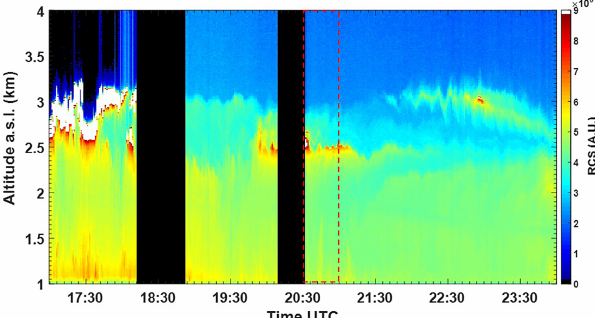
Figure 4. EARLINET IISTA-CEAMA lidar RCS time series at 532nm, 16 June 2016 (17:00 to 00:00UTC). The sunset estimated for this day was at 21:30UTC local time.